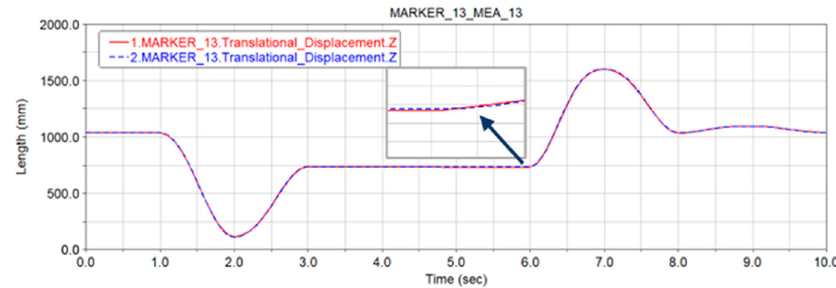
Figure 14. Comparison of simulation displacement curves in the z ‐ direction.